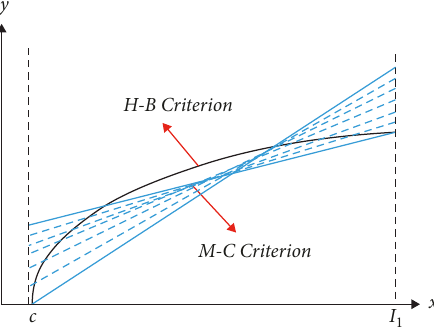
Figure 6: Approximately hourglass-shaped equivalent M–C line